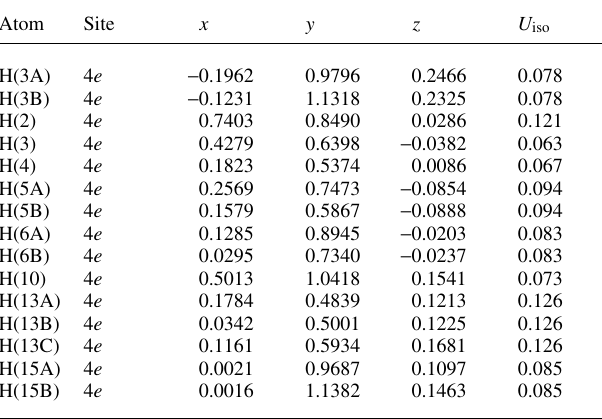
Table 2. Atomic coordinates and displacement parameters (in Å 2 )